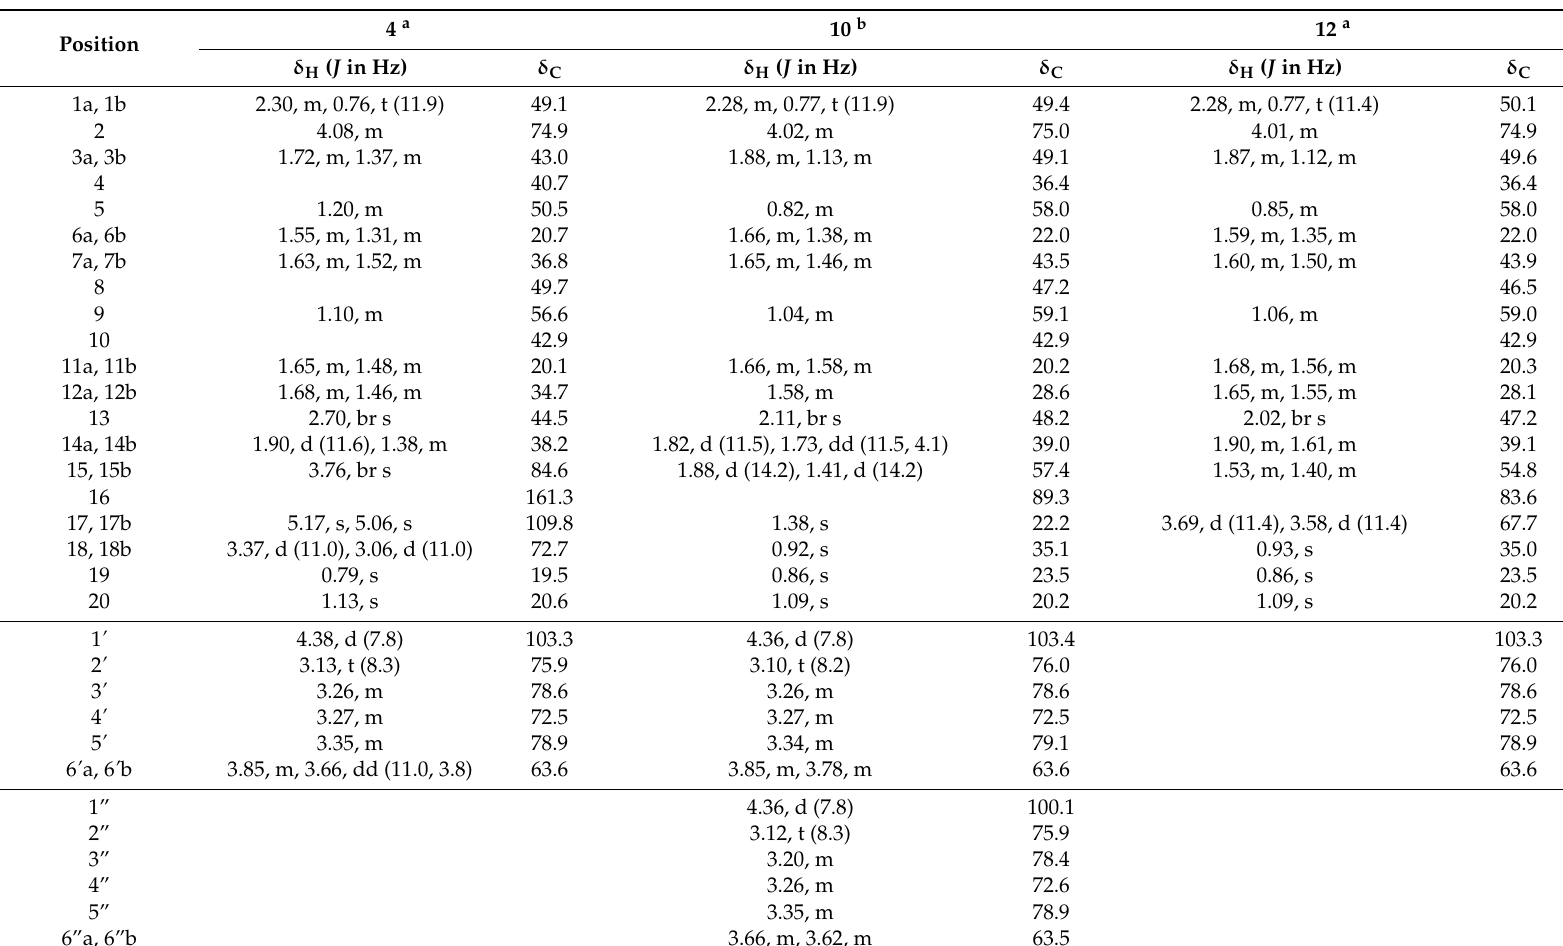
Table 1. 1 H- and 13 C-NMR spectral data of 4 , 10 and 12 in CD 3 OD ( δ in ppm; J in